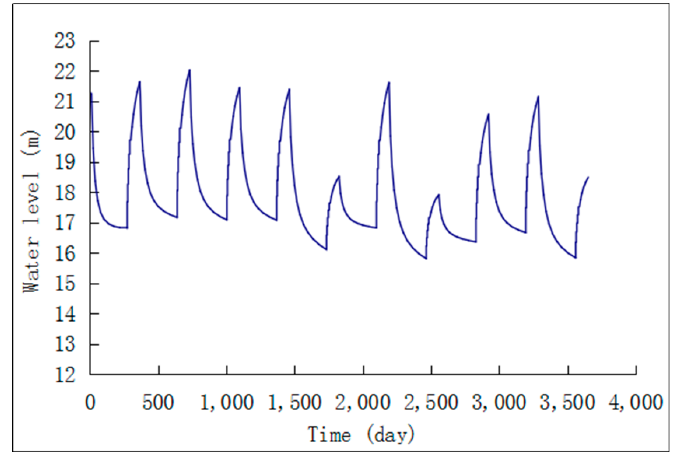
Figure 3. Prediction curve of water level change in the LK11 well.